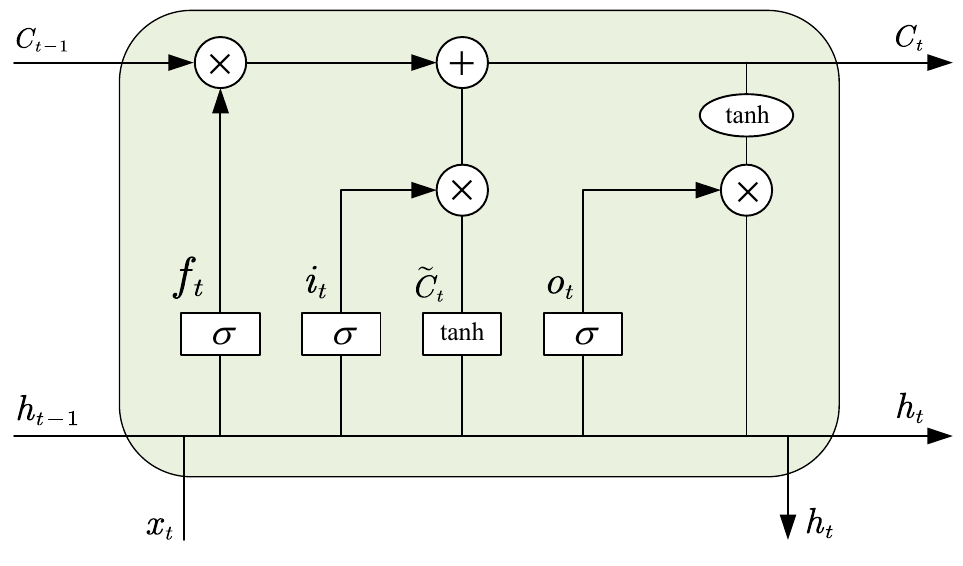
Figure 1. The structure of LSTM unit